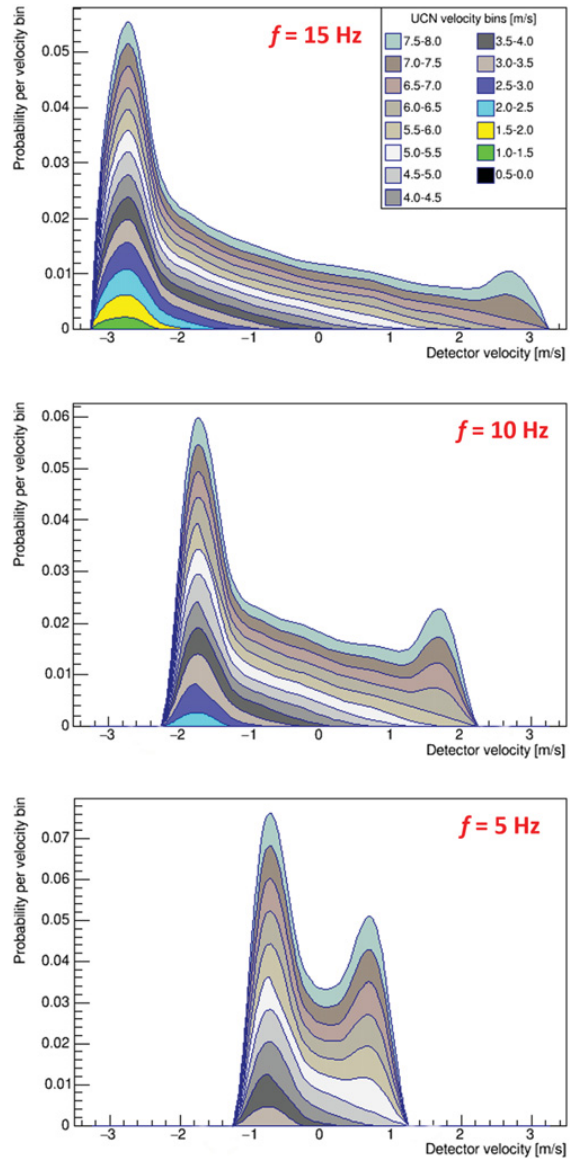
Figure 6. Detector velocity profiles corresponding to the UCN velocity bins for a uniform distribution of the initial velocity and with selected oscillation frequencies.